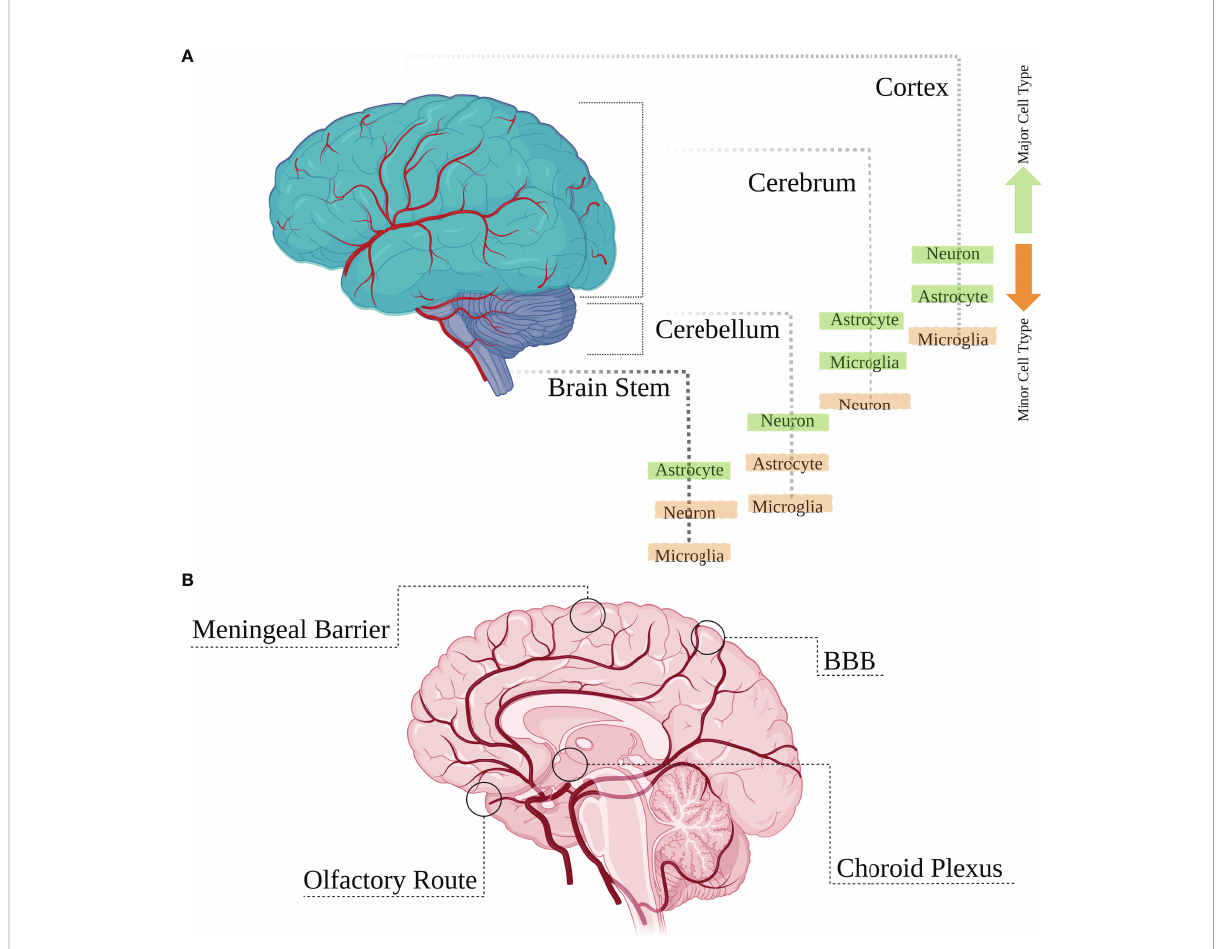
FIGURE 1 Main brain regions and cell types. (A) The brain is mainly composed of the cerebrum, cerebellum and the brain stem which are overlaid by the outermost layer called the cortex. Various cell types are distributed heterogeneously within different regions of the brain with some cell populations having higher or lower densities. (B) These brain structures are protected by anatomical restrictive barriers (choroid plexus, meninges, blood brain barrier (BBB), and olfactory epithelium) which create an interface between cerebrospinal fl uid (CSF), blood and brain parenchyma and are also considered as entry portals for several